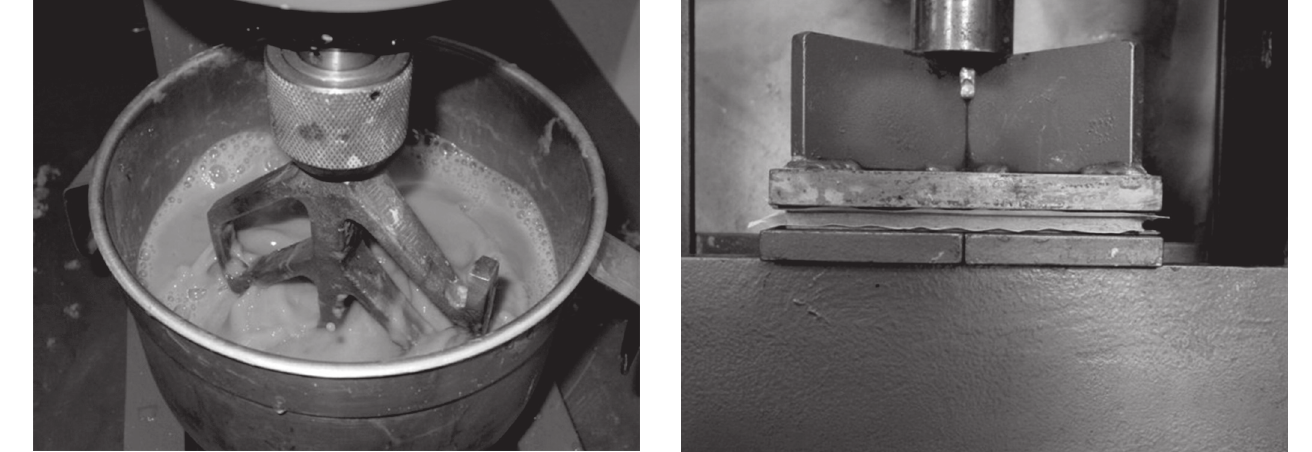
Figure 4. Mechanical